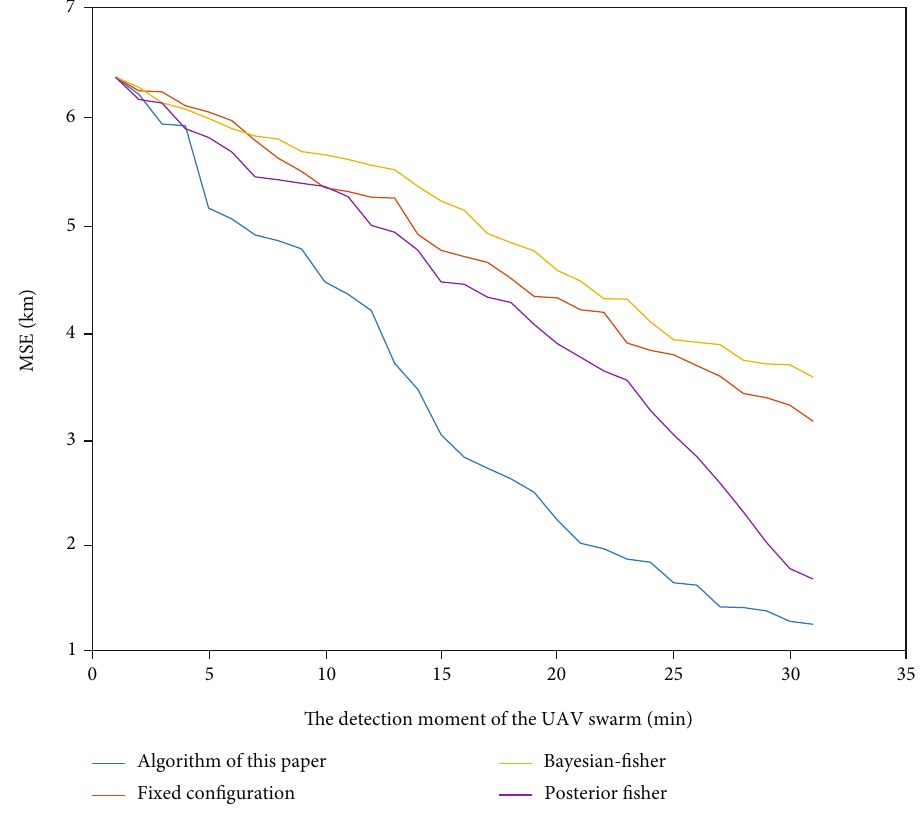
Figure 7: MSE comparison of di ff erent detection